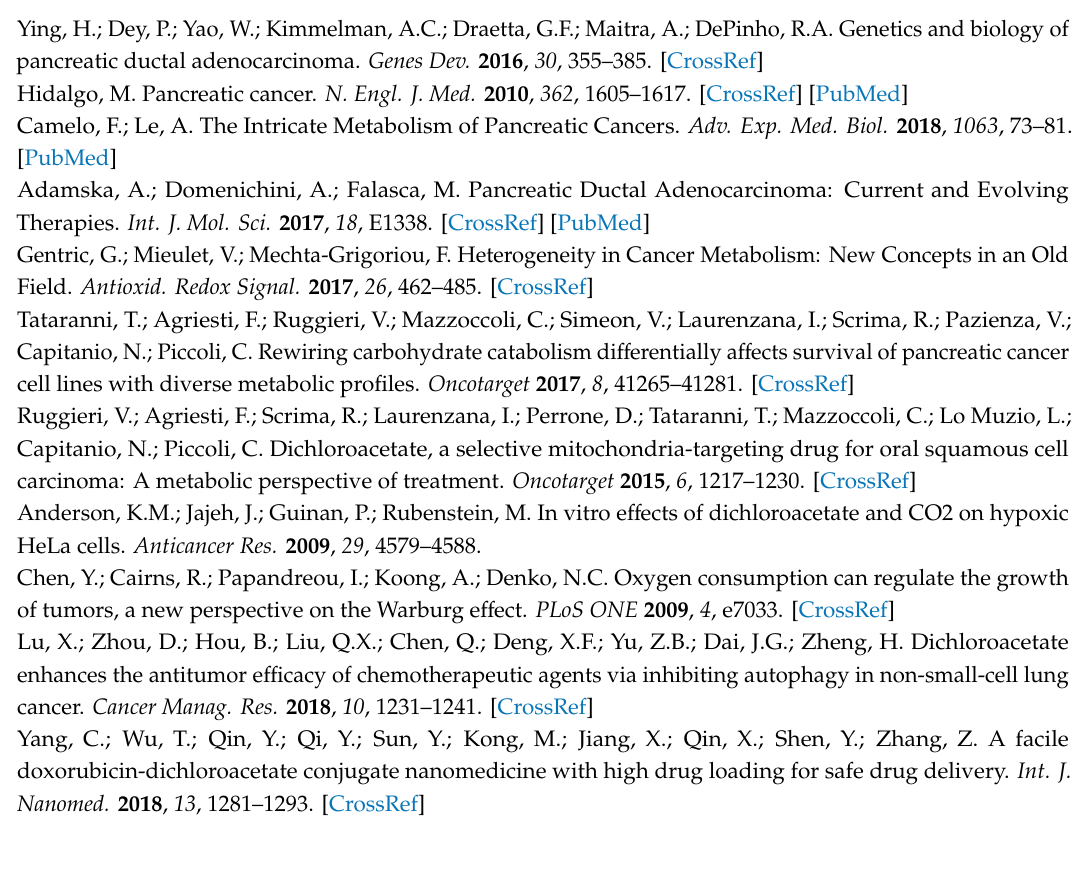
Figure S1: E ff ect of DCA on cell proliferation assessed by XCELLigence in medium containing low glucose; Figure S2: Scratch-healing; Figure S3: E ff ect of DCA on lactate production; Figure S4: E ff ect of 24 h DCA treatment on metabolic fluxes; Figure S5: Comparative e ff ect of DCA on the metabolic fluxes in PDAC cell lines under condition of low glucose (LG) and high glucose (HG) culturing; Figure S6: Protein expression of factors involved in mitochondria fusion–fission (OPA1, MFN1 / 2); Figure S7: Assessment of stemness in PDAC cell